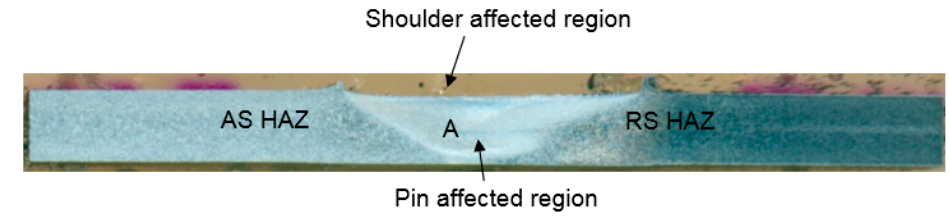
Figure 3. Schematic diagram showing the region A where optical micro-graphs are analyzed and local strain rate is